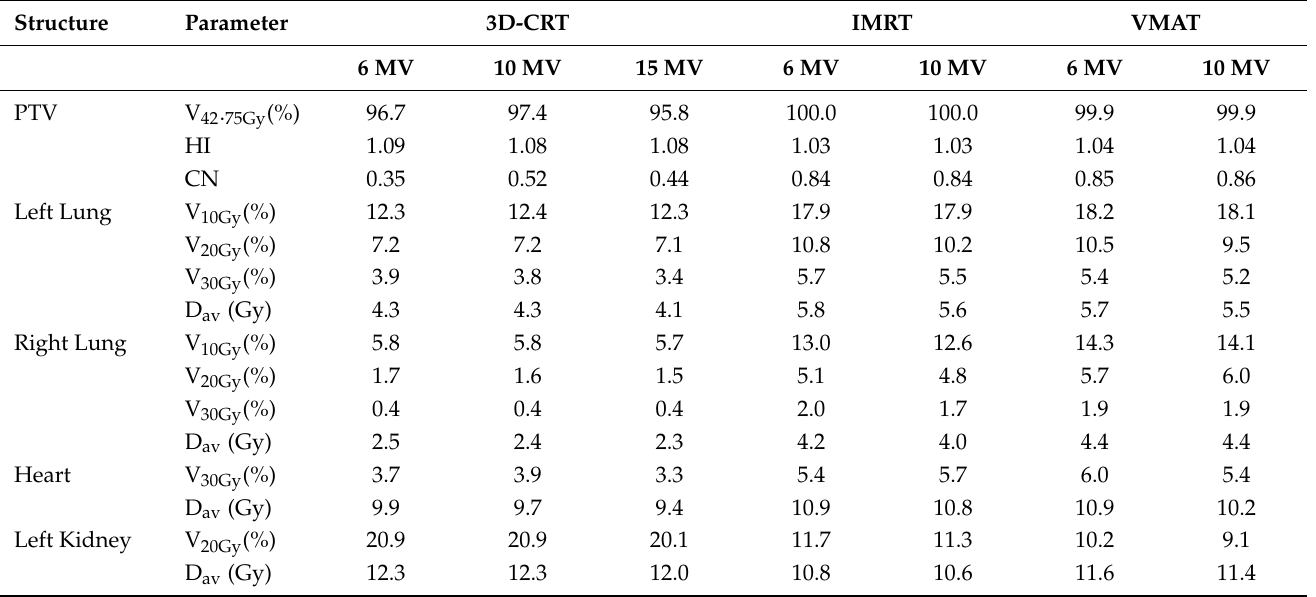
Table 4. Dosimetric parameters for the PTV and OARs derived from radiation therapy plans for gastric cancer on a computational phantom representing an adult female